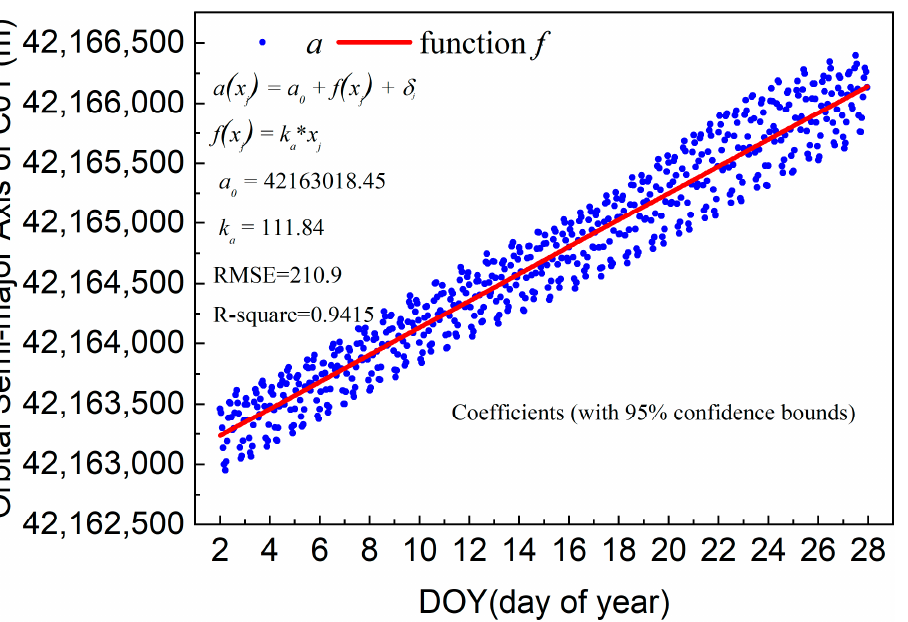
Figure 3. Time series values of orbital semimajor axis for C01 from 2–27 January 2015. In Figure 3, the blue points indicate the time series values of the orbital semimajor axis for C01. The orbital semimajor axis trend is linear due to the long-term comprehensive influence from multiple planets. The red line indicates the function f + a 0 , which is fitted using the data from 2–27 January 2015. The fitting coefficients of function f are also shown in Figure 3: a 0 is 42,163,018.15 m and k a is 111.84 m/day. In addition, the measured orbital semimajor axis also includes short-term periodical variation of the orbital semimajor axis due to the short-term comprehensive influence from multiple planets, random error, and orbital semimajor axis calculation error, which is reflected in δ j and root mean square error (RMSE) of 210.09 m. The coefficient of determination (R-square) is 0.9415, and the analyzed variation characteristics of the orbital semimajor axis is indicated by the data fitting results. In addition, time series values of the orbital semimajor axis for C01 from 11 February 2013 to 12 December 2019 were calculated. In Figure 4, the blue points indicate the time series values of the orbital semimajor axis for C01. The orbital semimajor axis trend is linear due to the long-term comprehensive influence from multiple planets. The results demonstrate that the variation characteristics of orbital semimajor axis can be described as a linear function. From the results we can know that the slope may change after orbit maneuvers, which were consistent before maneuvers. Additionally, when the value of the orbital semimajor axis is greater than warning value, the long-term rate of the orbital semimajor axis and the warning time can be